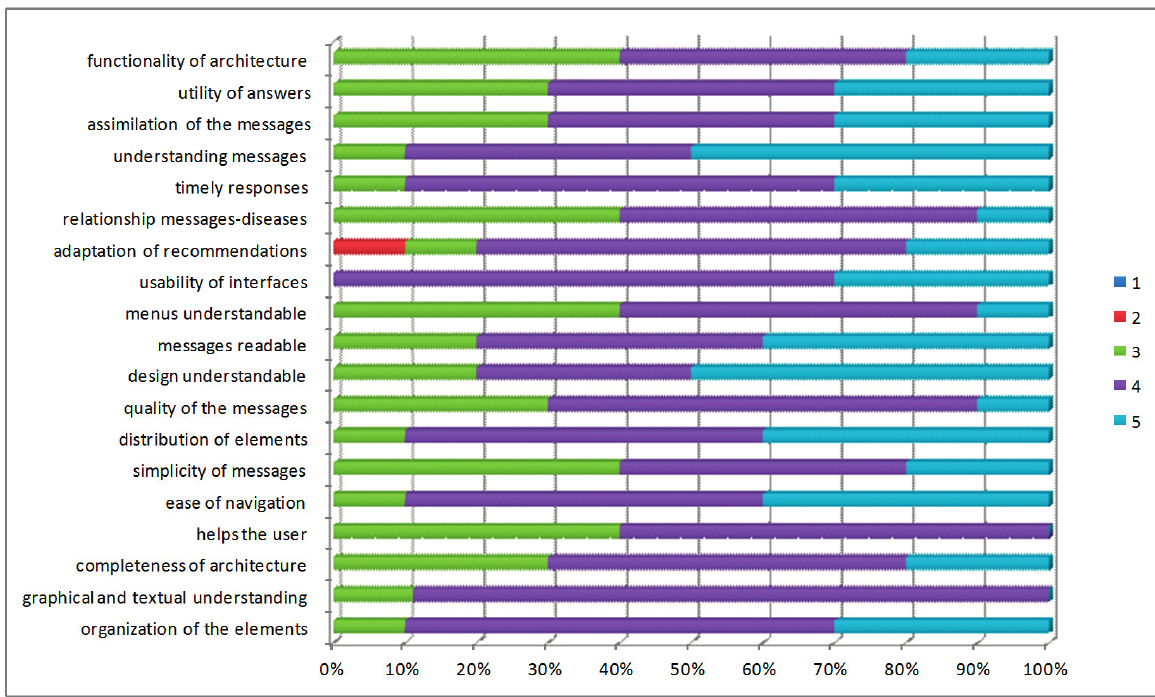
Figure 4. Quality aspects by the end-user